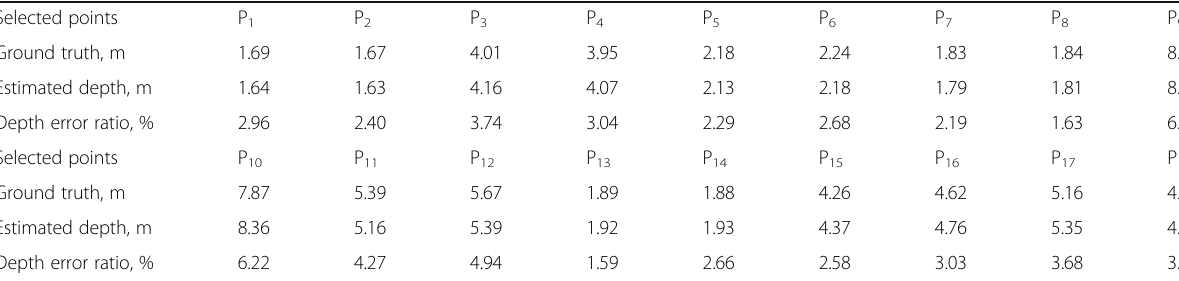
Table 6 Depth estimation results compared with ground truth depth data Selected points P